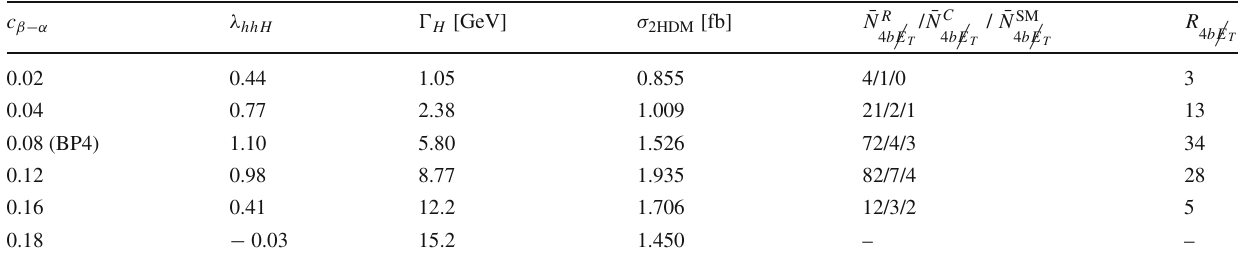
√ Table 8 R s = 3000 GeV. Also shown are λ hhH , the total widths (cid:16) H , total cross sections, σ , and event for BP4 for different c β − α at 4 b (cid:3) E T numbers, ¯ N , as defined in the text. “–” indicates values that cannot be evaluated due to a too small number of